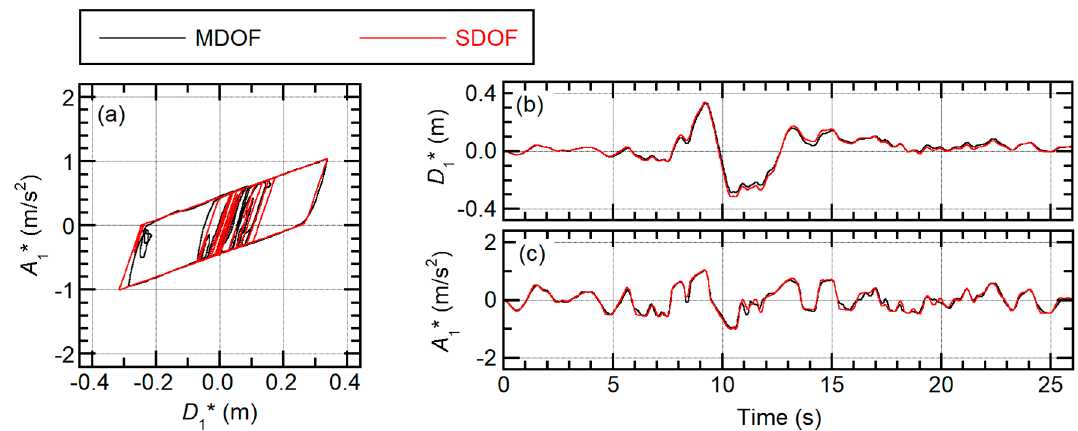
Figure 19. Comparisons between first modal response calculated from time-history analysis of multi-degree-of freedom (MDOF) and SDOF models (Art-L00, 100%): ( a ) A 1* - D 1* relationship comparisons; ( b ) time-history of D 1* ; ( c ) time-history of A 1* .